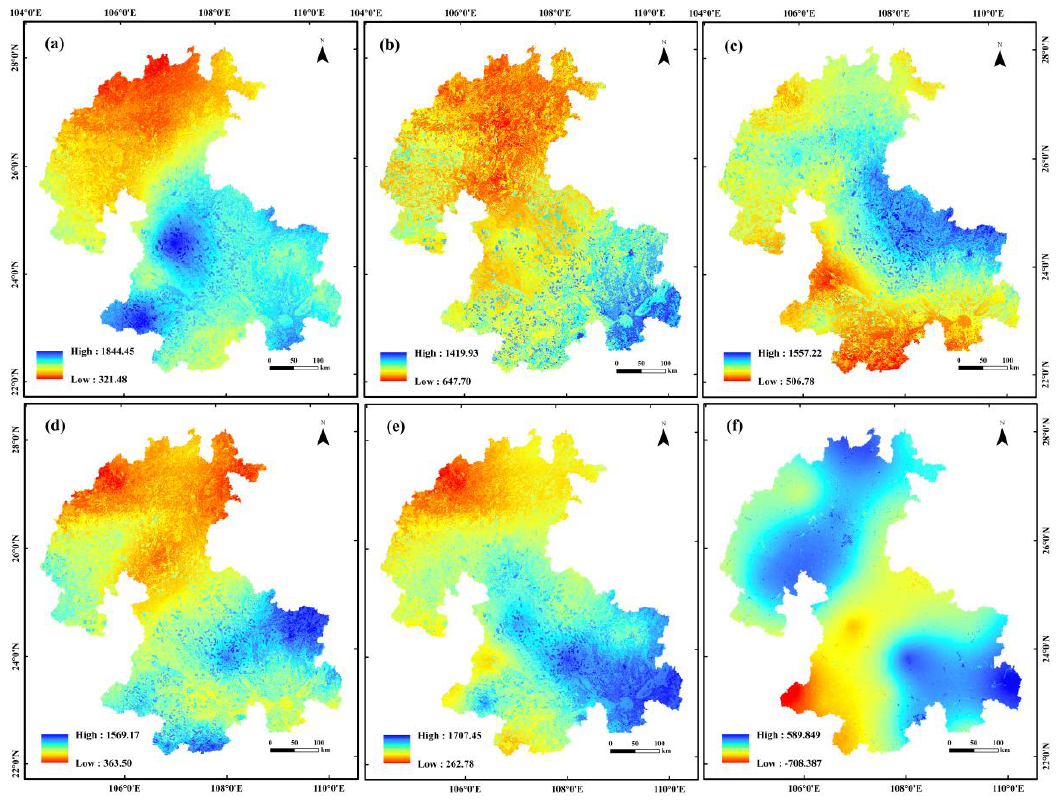
Figure 4. Water yields from 1990 to 2010, ( a ) 1990, ( b ) 1995, ( c ) 2000, ( d ) 2005, and ( e ) 2010, and ( f ) water yield variation from 1990 to 2000 (all units are in mm).